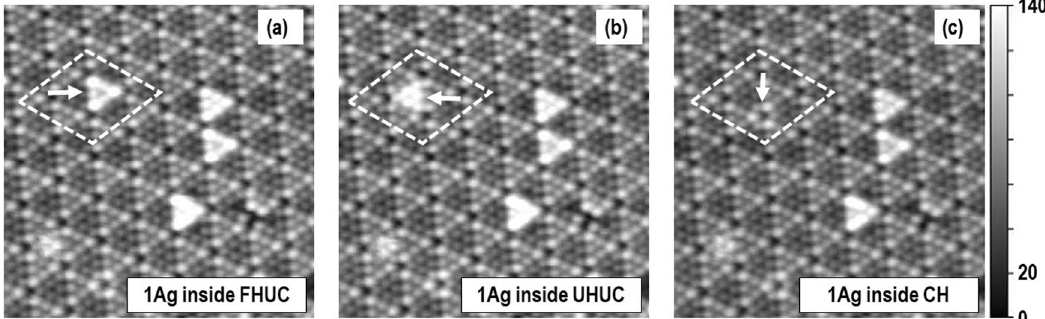
Fig. 2 Intercell cell hopping and jumping to a corner hole. Three consecutive fi lled states STM images ( a ), ( b ), and ( c ) separated by one minute obtained at RT (tunneling conditions: − 1.8 V, 177 nA, size: 20×20 nm 2 ). At ( a ) the diffusing Ag atom is denoted by the arrow. The area where the diffusion takes place is denoted by the diamond shape outline. In ( a ) diffusing atom is in FHUC and in ( b ) the same Ag atom is visible in UHUC. In ( c ) the diffusing Ag atom is in CH. In the images we can see one more corner hole that is occupied by the Ag atom and during this process it stays unchanged. Original fi les in ( a ), ( b ), and ( c ) are provided in Supplementary Data 2: ( a ) m326_ori.par, m326_ori.tf0, m326_ori.tb0. ( b ) m328_ori.par, m328_ori.tf0, m328_ori.tb0. ( c ) m333_ori.par, m333_ori.tf0,